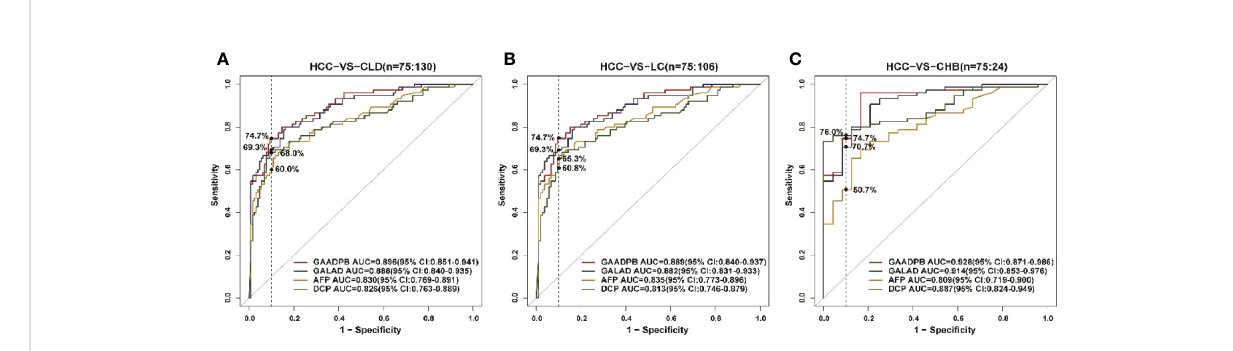
FIGURE 4 ROC curve analysis of GAADPB in different disease subgroups of the test set. (A) , HCC from CLD (B) , HCC from LC (C) , HCC form CHB. The vertical line represented speci fi city was at 90%. HCC, hepatocellular carcinoma; LC, liver cirrhosis; CHB, chronic hepatitis B; HC, healthy controls.